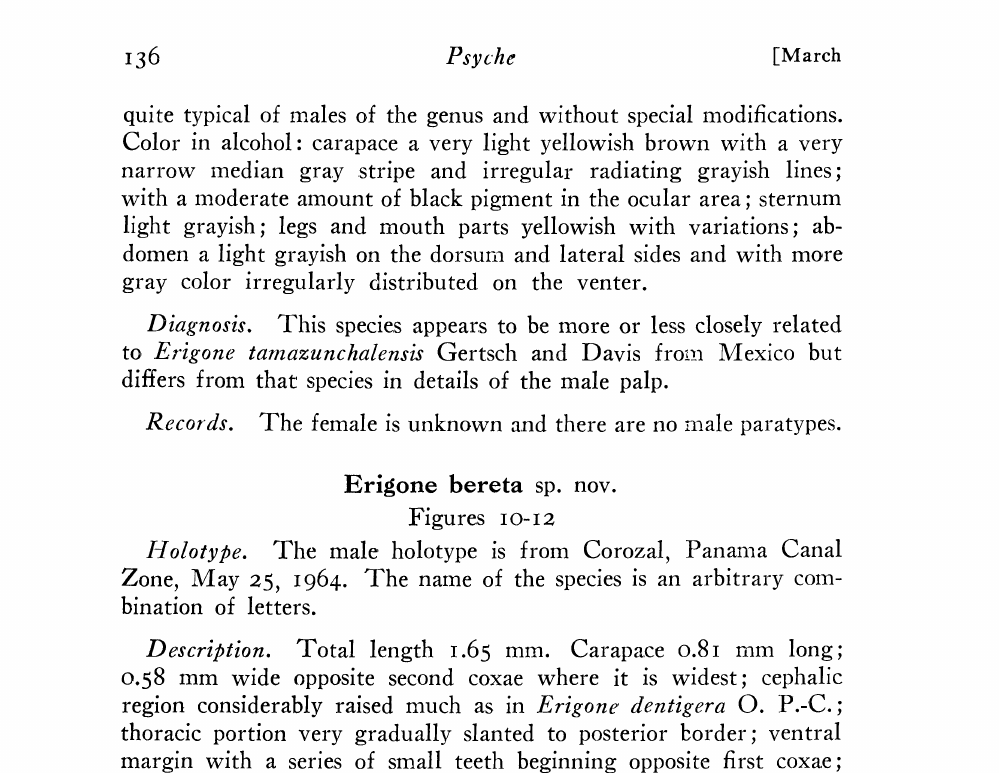
quite typical of males of the genus and without special